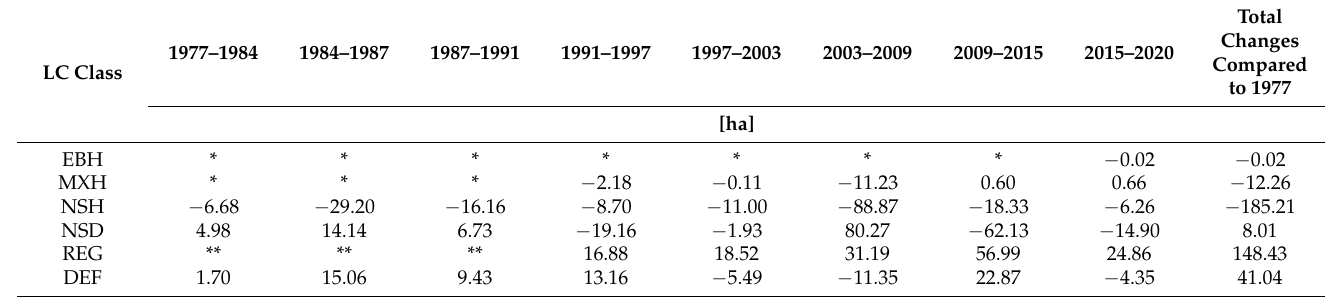
Table 3. Changes in the area of LC classes relative to the previously analyzed date in subarea A. *—no change was observed, **—class not detected.